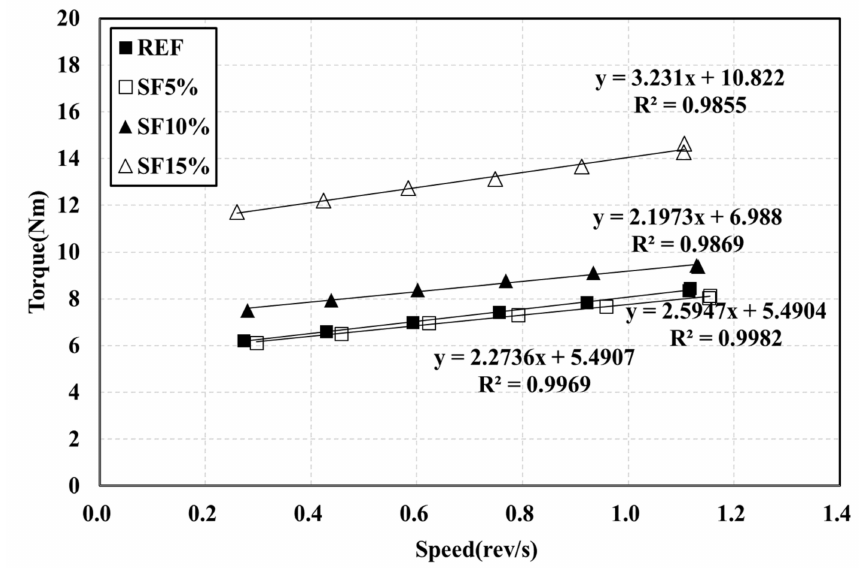
Figure 15. Rheological measurement results according to Jeon’s mixing ratio.